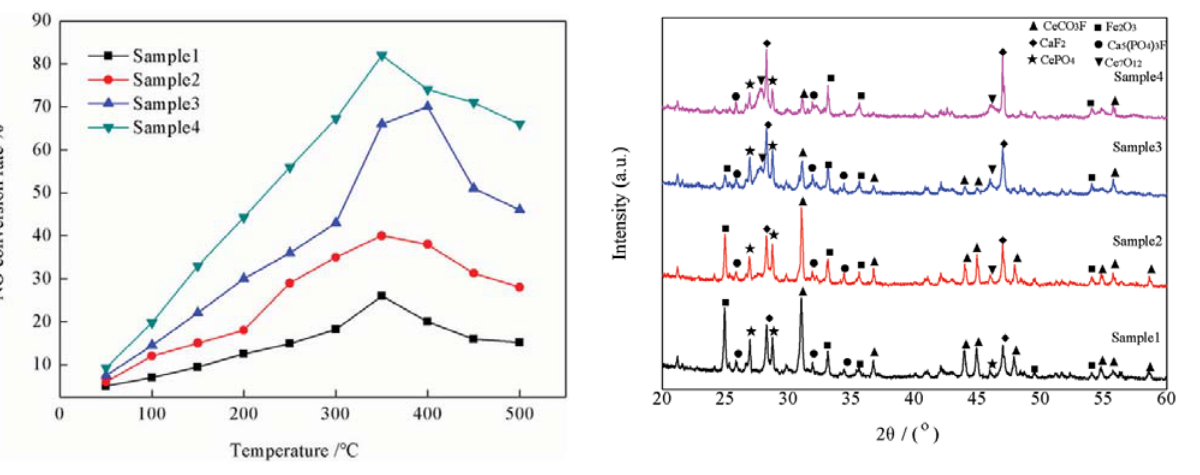
Figure 10: XRD of the different samples roasting at